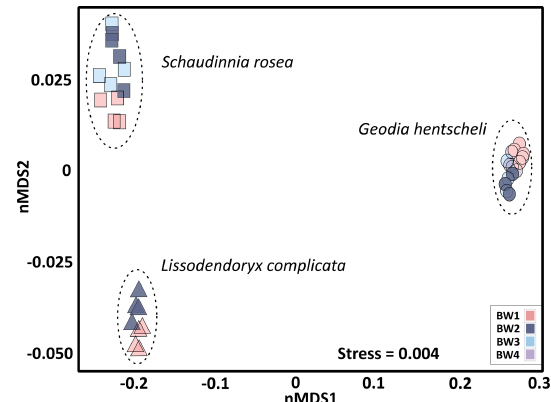
Figure 5. Sponge microbial community composition visualized by a non-metric multidimensional scaling plot on weighted UniFrac distances. Each marker is one microbial community, with sym- bols representing the sample sub-type (i.e. sponge species) and colours indicating the near-bed water cluster present at the respec- tive sponge sampling